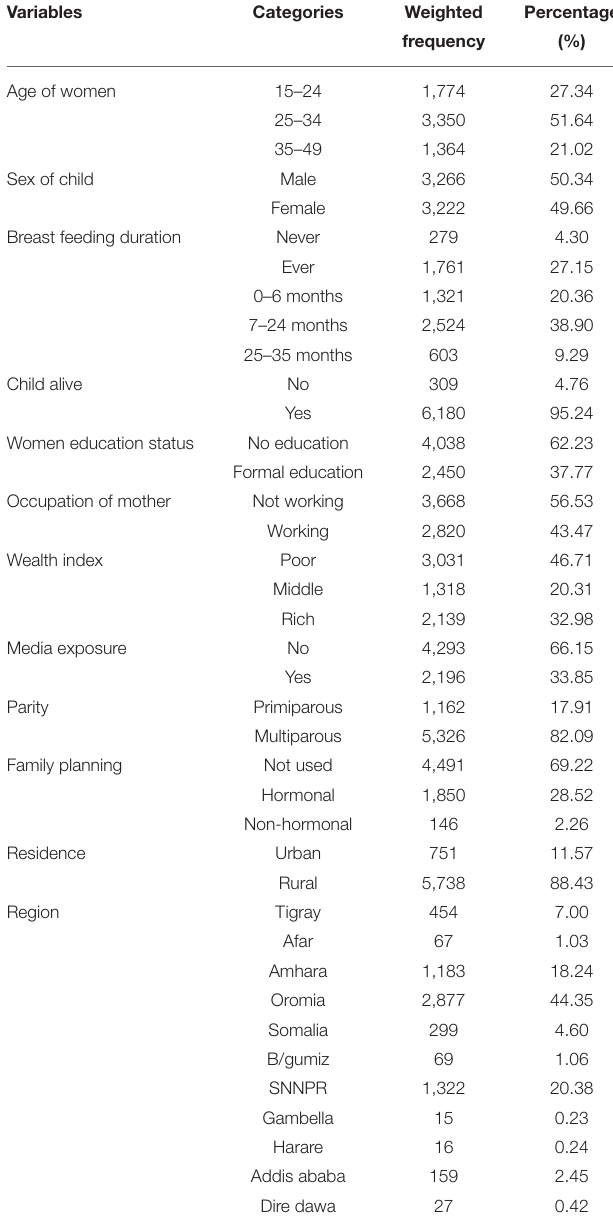
TABLE 1 | Socio-demographic characteristics of the study population in Ethiopia, 2016 Ethiopian Demographic and Health Survey (EDHS).